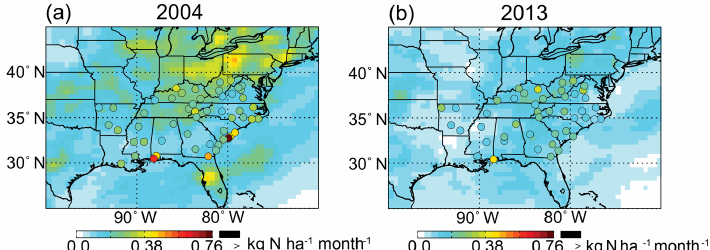
Figure 3. Nitrate wet deposition flux (kgNha − 1 month − 1 ) from NADP (circles) and AM3 (background) during July–August of 2004 and